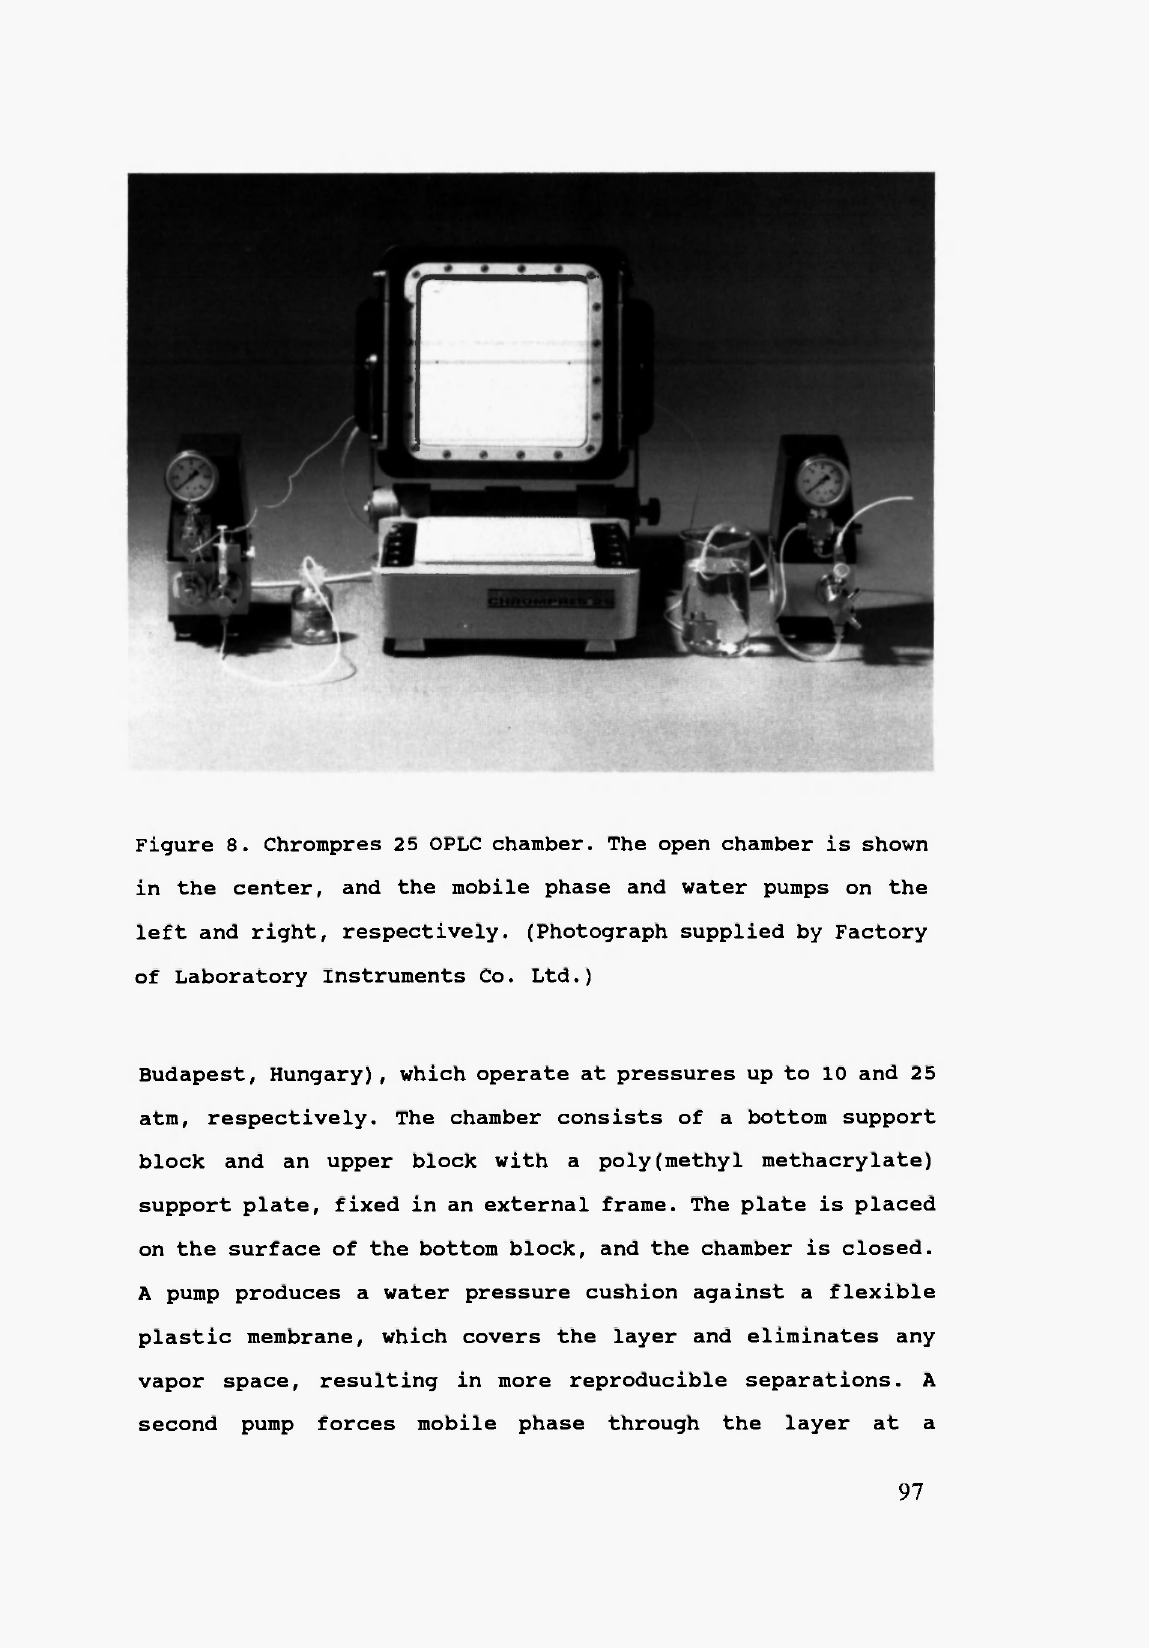
Figure 8. Chrompres 25 OPLC chamber. The open chamber is shown in the center, and the mobile phase and water pumps on the left and right, respectively. (Photograph supplied by Factory of Laboratory Instruments Co.